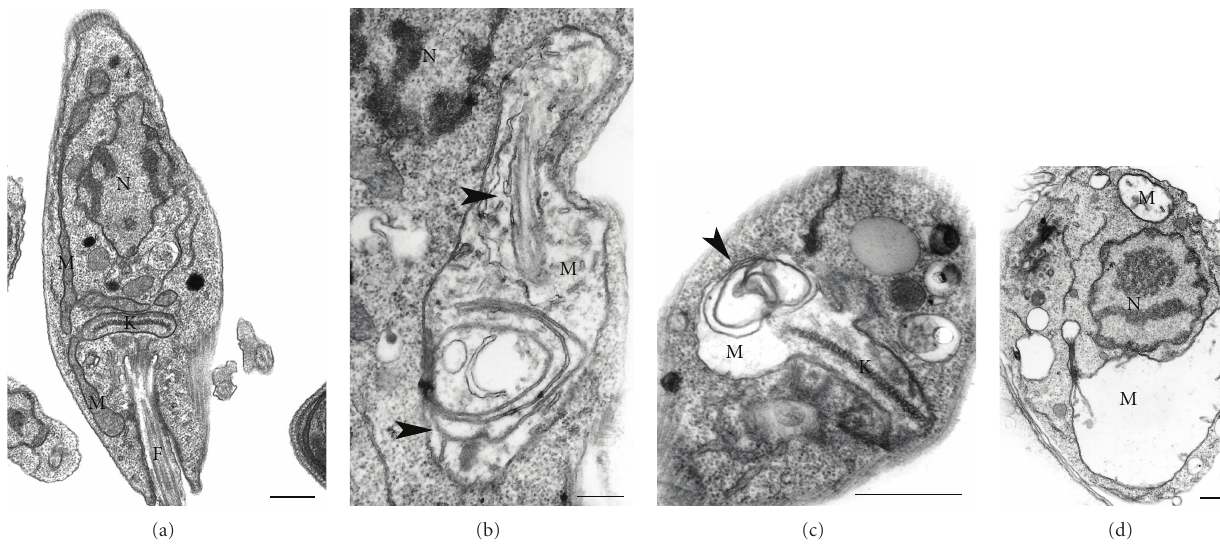
Figure 5: Ultrathin sections of L. amazonensis promastigotes control (a) and treated with azasterols, known inhibitors of the Δ 24(25) -sterol methyltransferase (b)–(d). (a) General overview of an untreated-parasite showing a normal ultrastructure of the mitochondrion (M), kinetoplast (k), flagellum (F) and nucleus (N). (b)–(d) Treated-parasites presenting severe alterations in the mitochondrion structure such as a disorganization of the internal membranes ((b) and (c), arrowheads ) and an intense and evident mitochondrial swelling with loss of the matrix content (b)–(d). Bars 0 . 5 μ